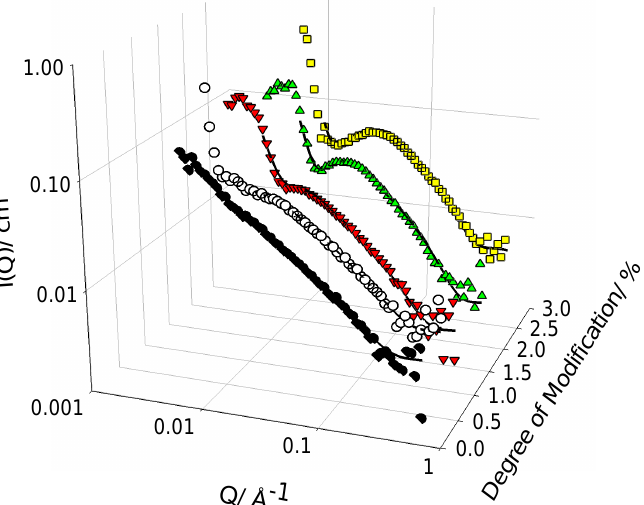
Figure 2. Small-angle neutron scattering (SANS) profiles from 1 wt% polymers with different degrees of charge